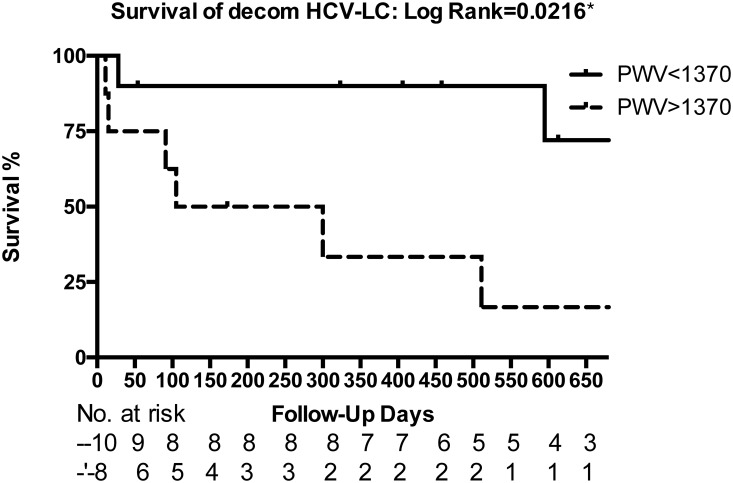
The Kaplan–Meier plot of one-point PWV> or <1370 cm/s predicted mortalities of patients with HCV related decompensated cirrhosis (Log-rank test p = 0.0216).The number of patients at risk on each time point is also shown in the bottom of the figure.